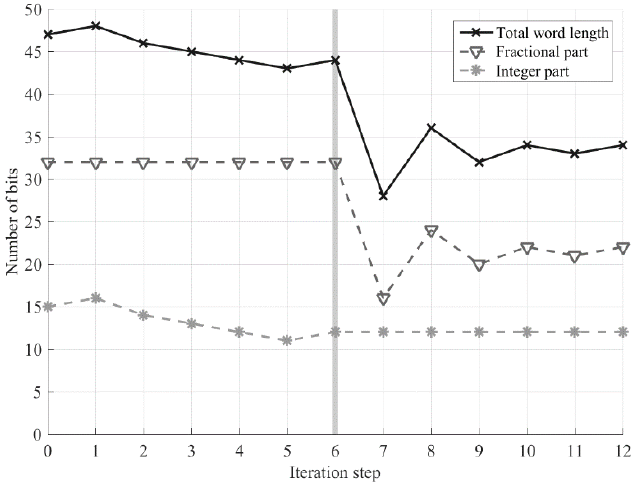
Fig. 6. Process of finding the number of bits for the IVGTT (Case A) implementation with the maximum error of 1 %. The gray bar emphasizes the change of optimization target – from the integer to fractional parts.